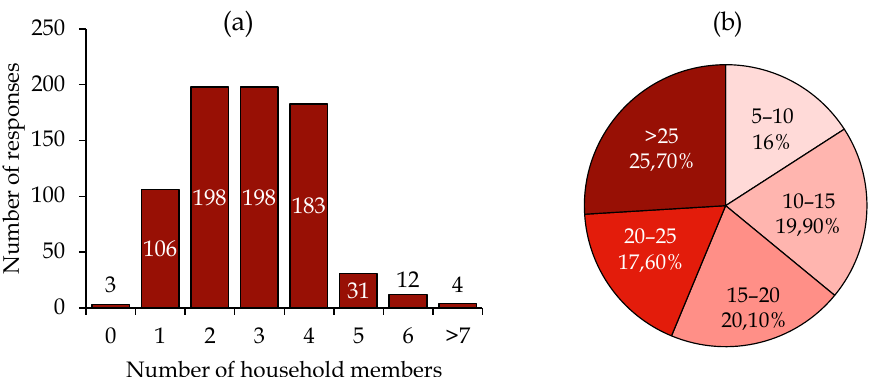
Figure 3. ( a ) Household members and ( b ) annual household income (in EUR1000s) of the partici ‐ pants.